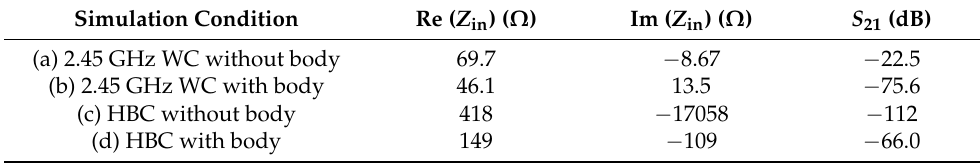
Table 1. Transmission characteristic S 21 under the four simulation